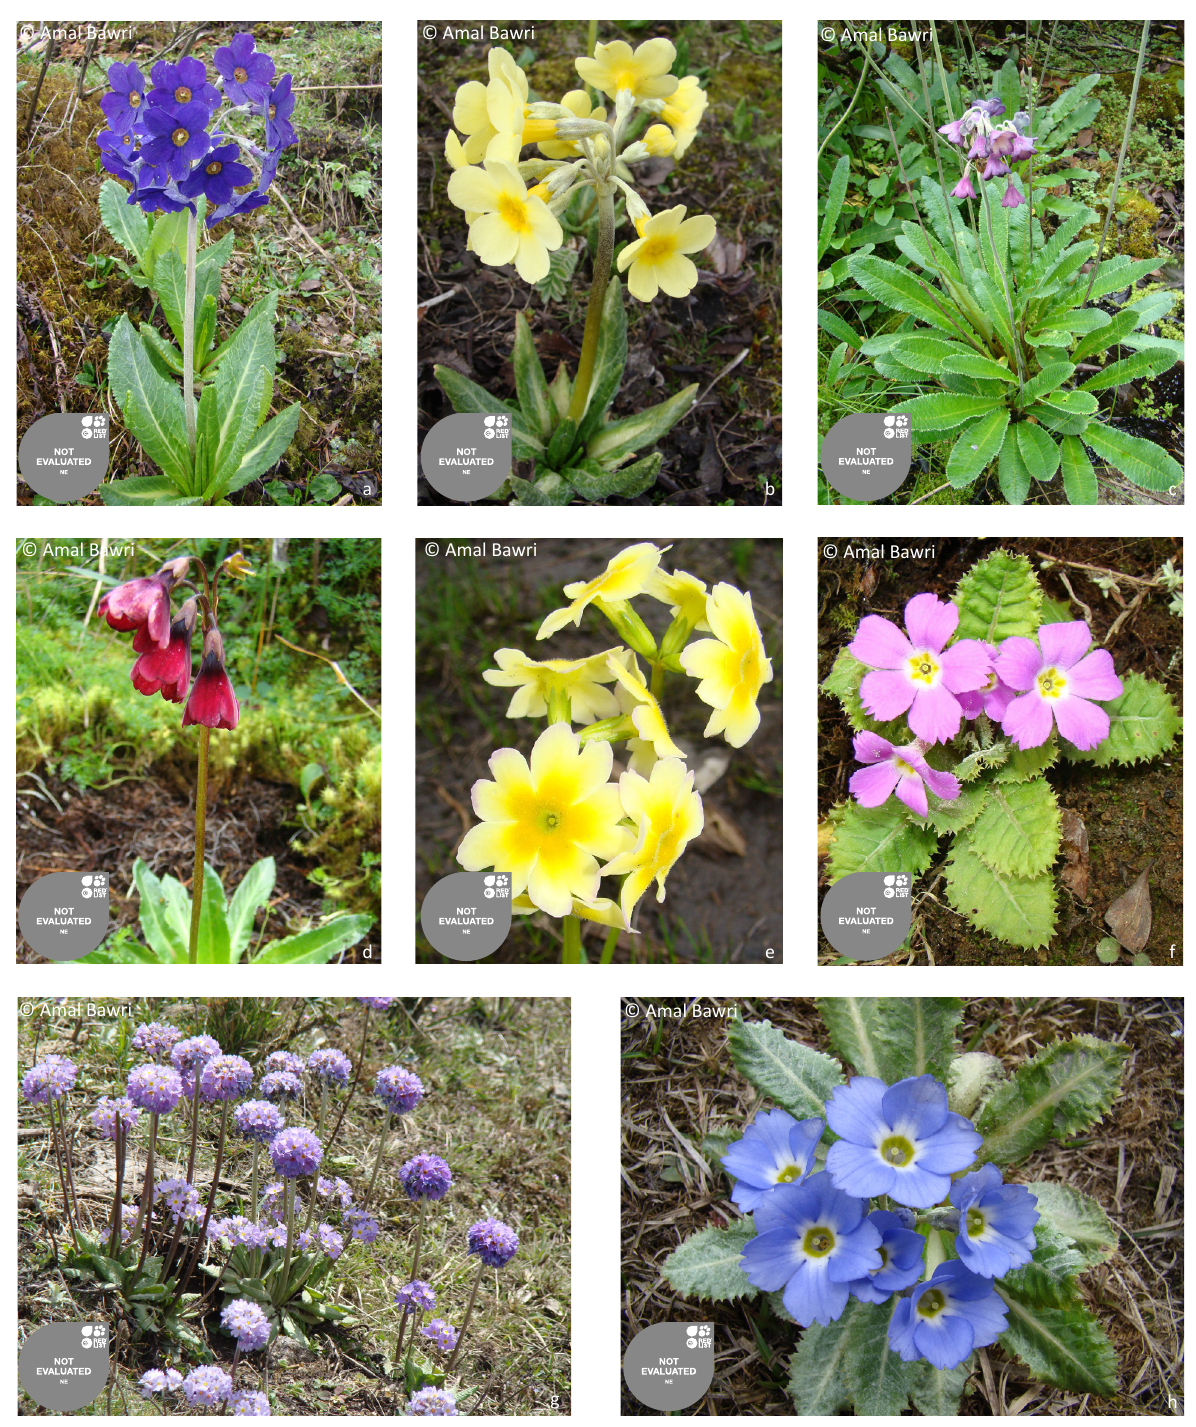
Image 1. Primula species in their natural habitat in Arunachal Pradesh. a - P. calderiana ssp. calderiana ; b - P. calderiana ssp. strumosa ; c - P. waltonii ; d - P. kingii ; e - P. dickieana ; f - P. gracilipes ; g - P . denticulata; h - P.